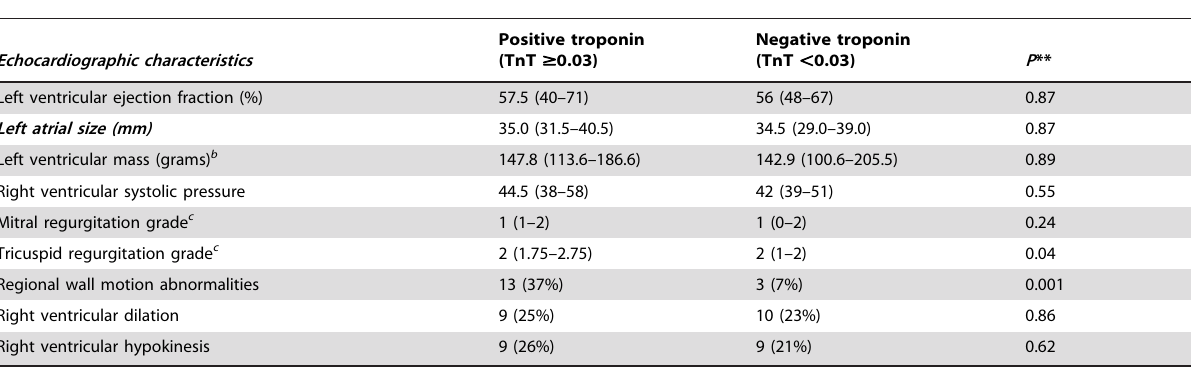
Table 5. Echocardiogram characteristics, by cardiac marker status (n=81).